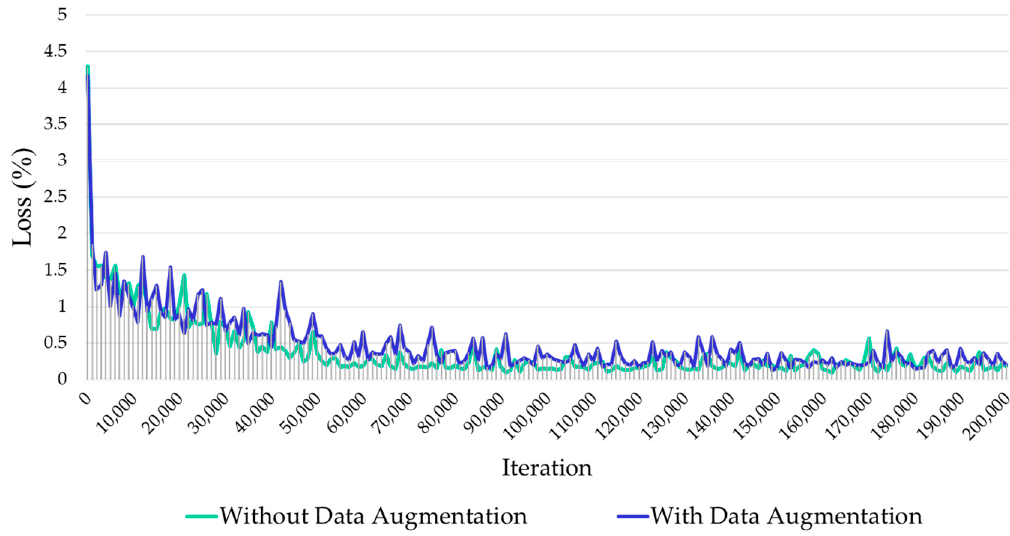
Figure 5. Training loss curve of our proposed approach. The comparison includes results with and without data augmentation. Our network efficiently learns the data while achieving a lower error rate at about one hundred thousand